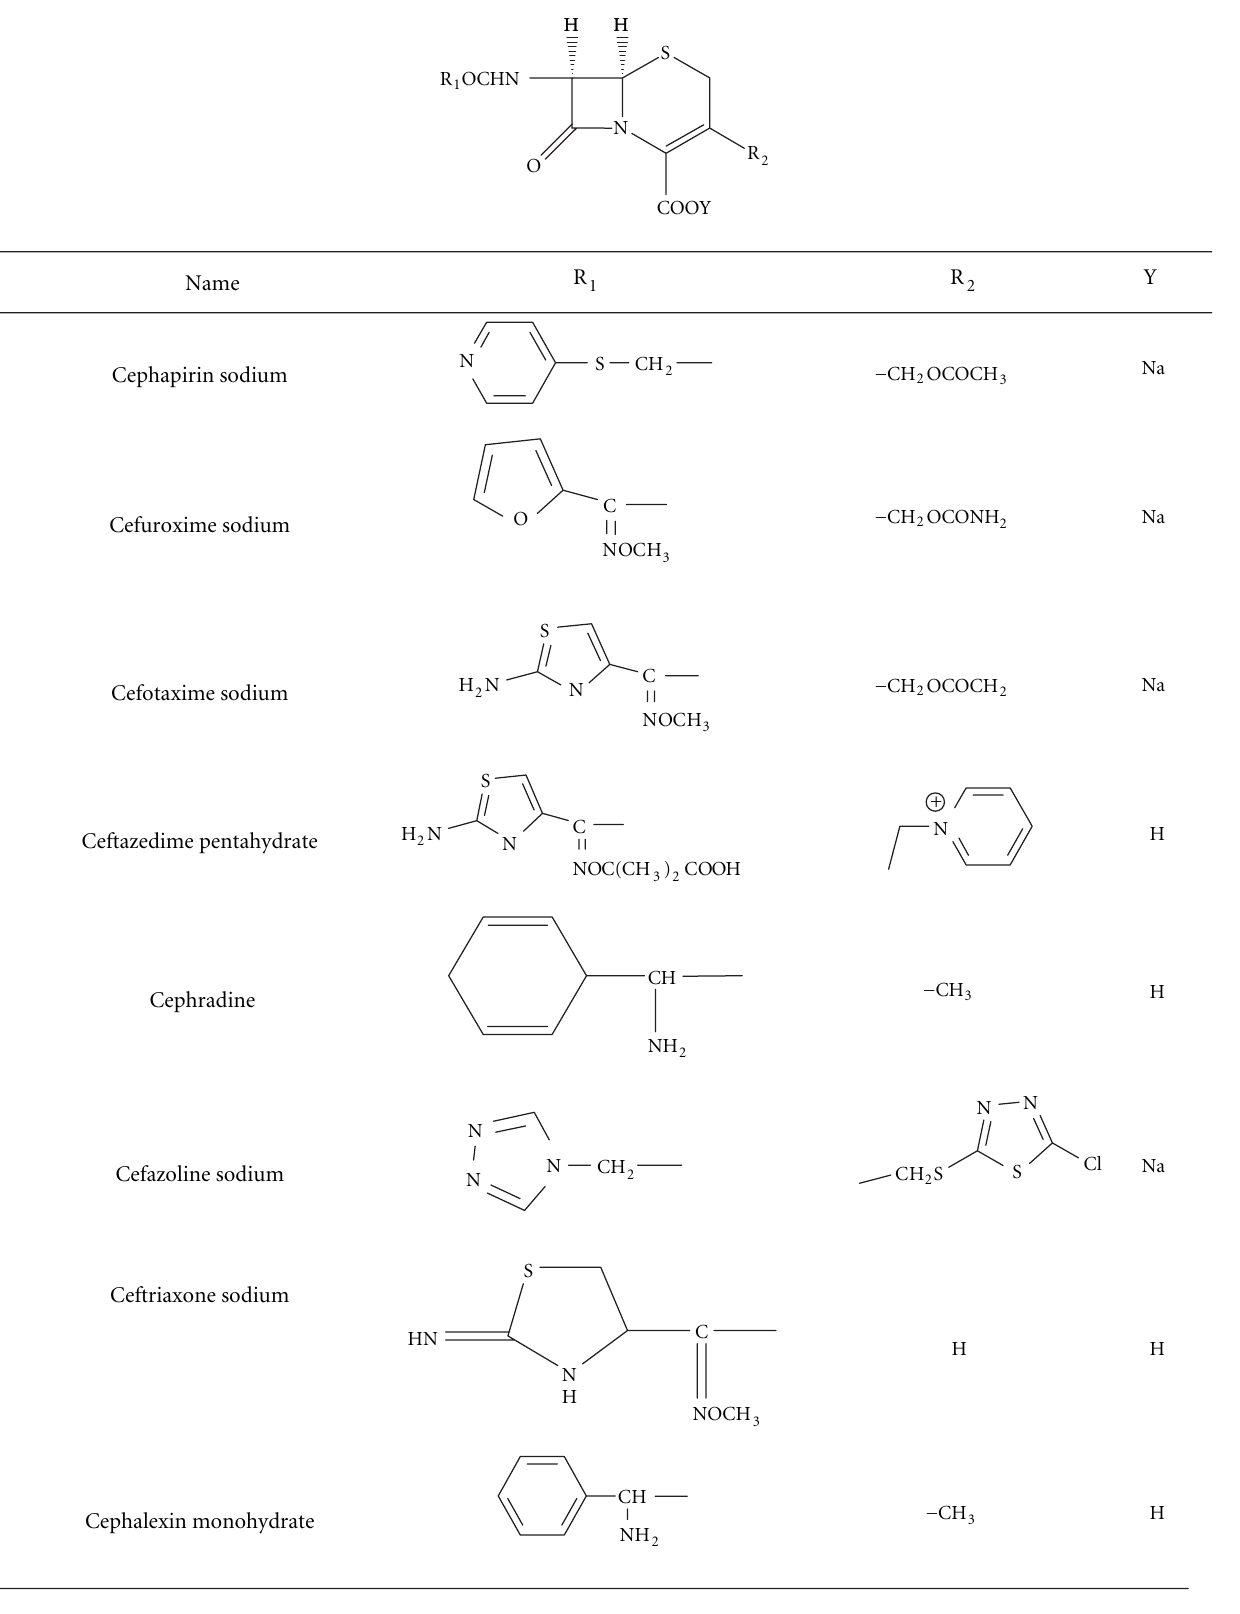
Table 1: Structural formula of the studied